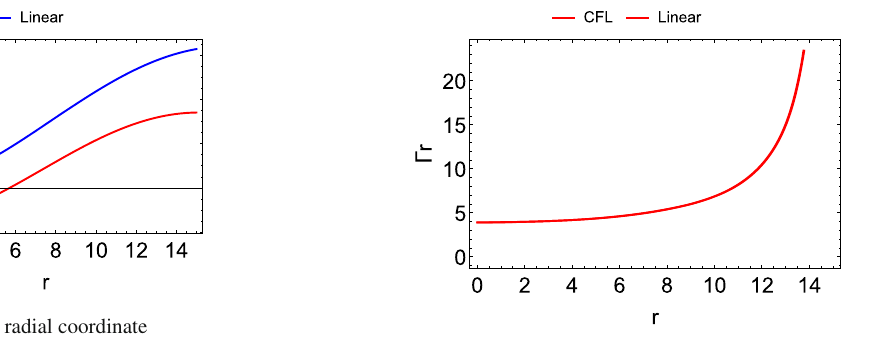
Fig. 8 Variation of Γ r with radial coordinate